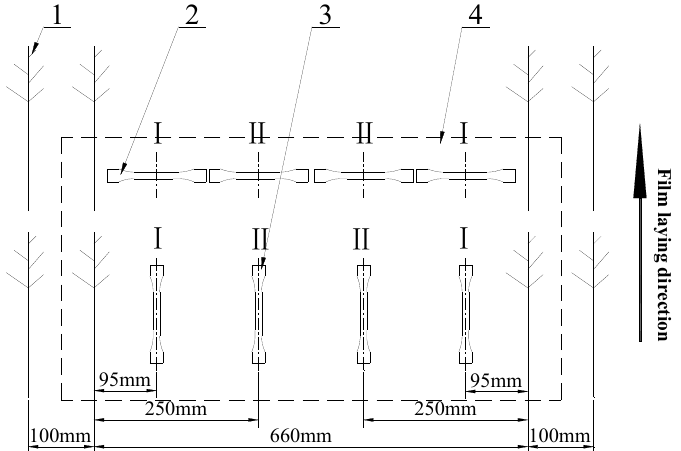
Figure 2. Schematic diagram of sampling location: 1—cotton plant, 2—vertical film sampling, 3—horizontal film sampling, 4—film sample piece, I—near ‐ end position, II—far ‐ end position.